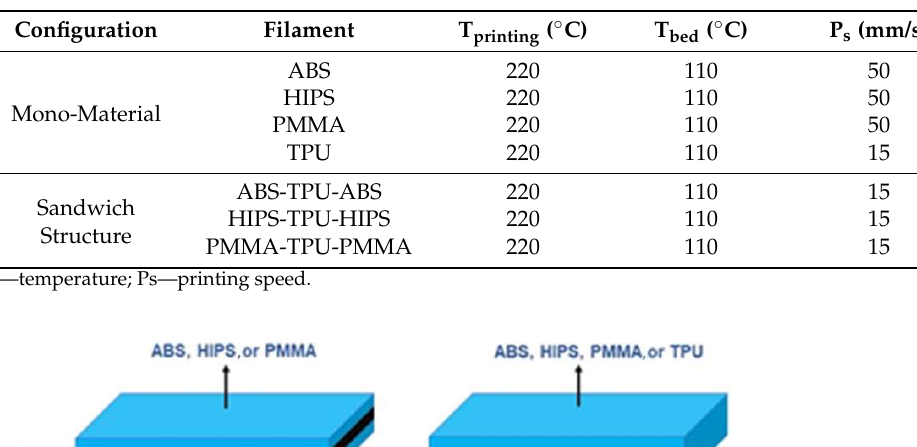
Table 1. Printing parameters of the printed specimens.